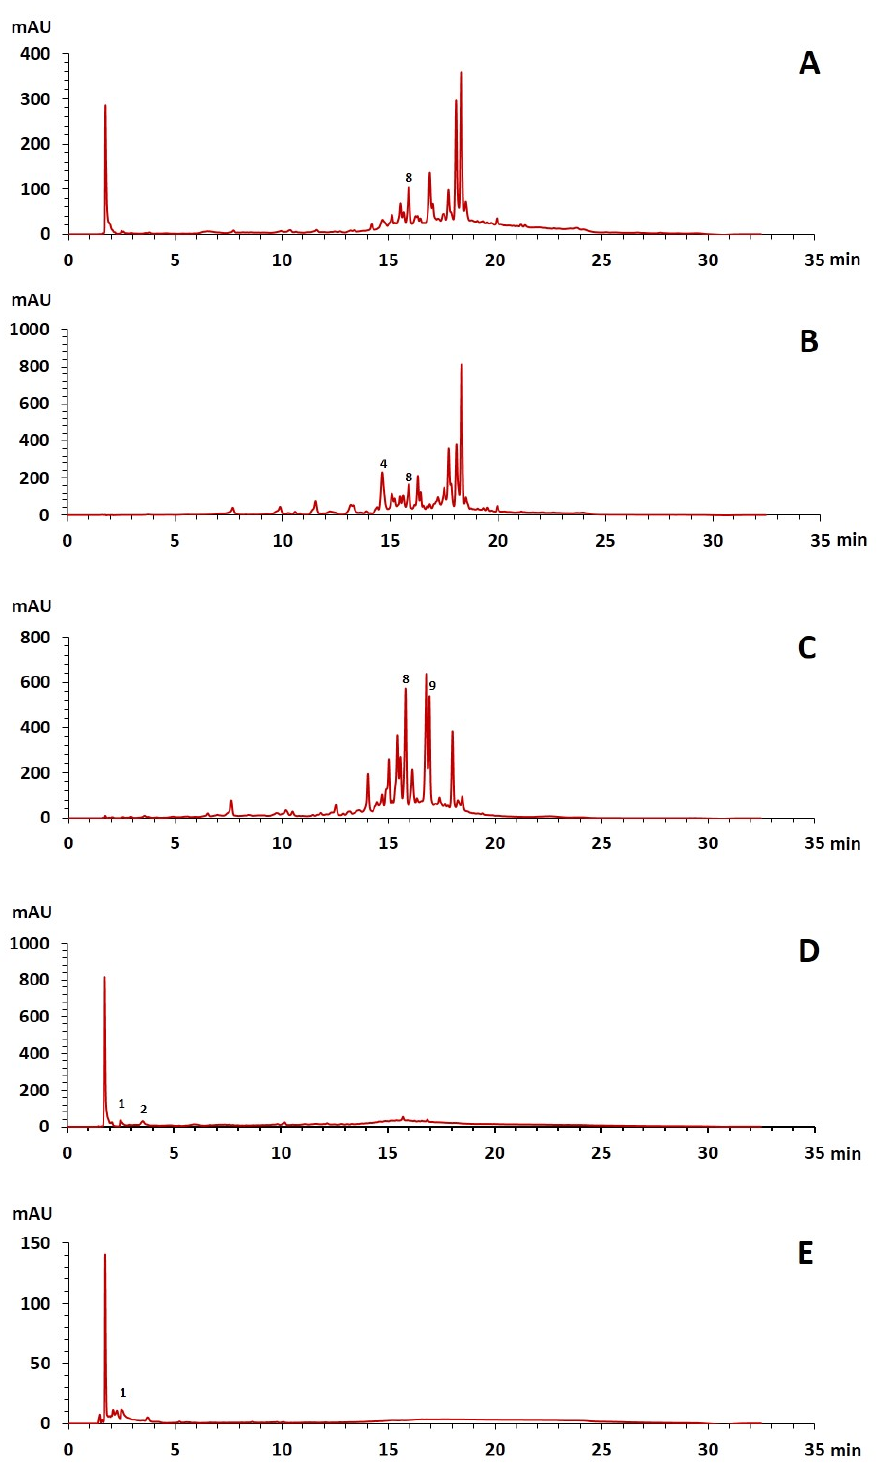
Figure 1. HPLC-DAD-UV analysis (280 nm) of phenolic compounds in the crude ethanol extract ( A ), chloroform ( B ), ethyl acetate ( C ), n -butanol ( D ), and water ( E ) fractions of roots of L. intricatum. Gallic acid ( 1 ), gentisic acid ( 2 ), p -coumaric acid ( 4 ), ferulic acid ( 8 ), trans -cinnamic acid ( 9 ). The experimental conditions are described in Section 2.5.